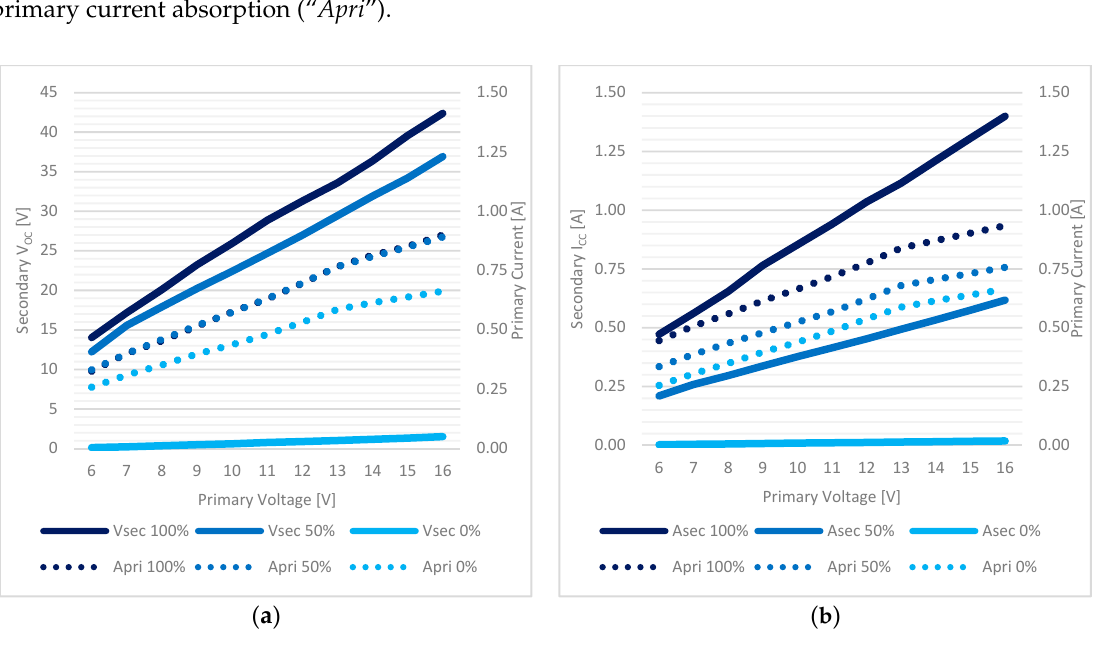
OC of the WPT system, ( b ) I CC